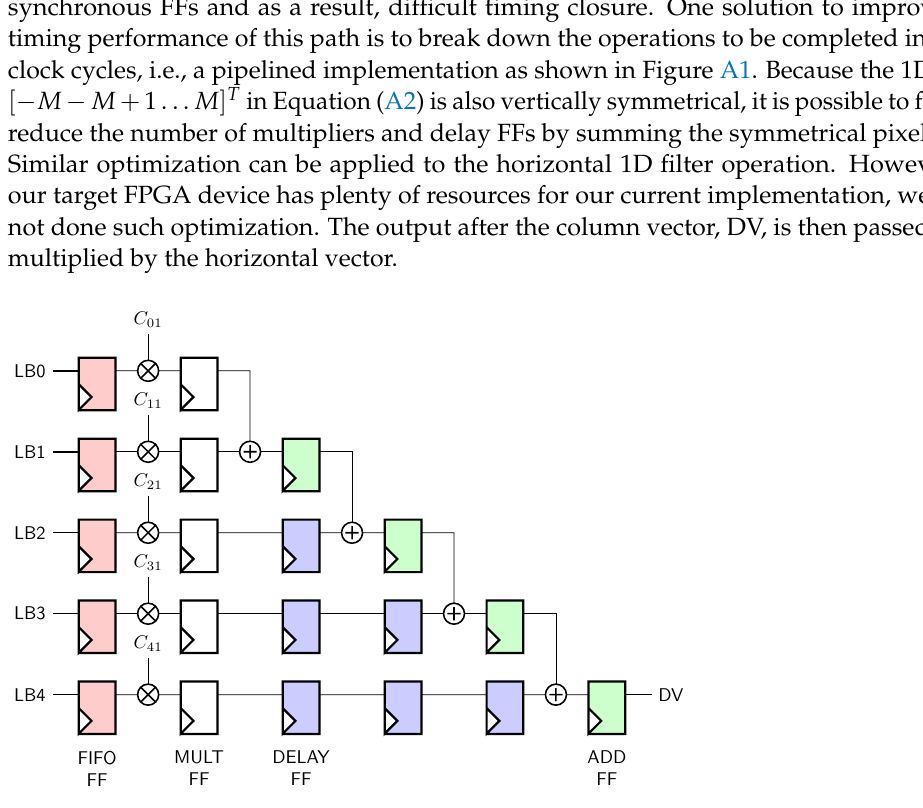
Figure A1. A fully pipe-lined design for the vertical filter operation. LB is the output of different line buffers and DV represents the output after applying the column